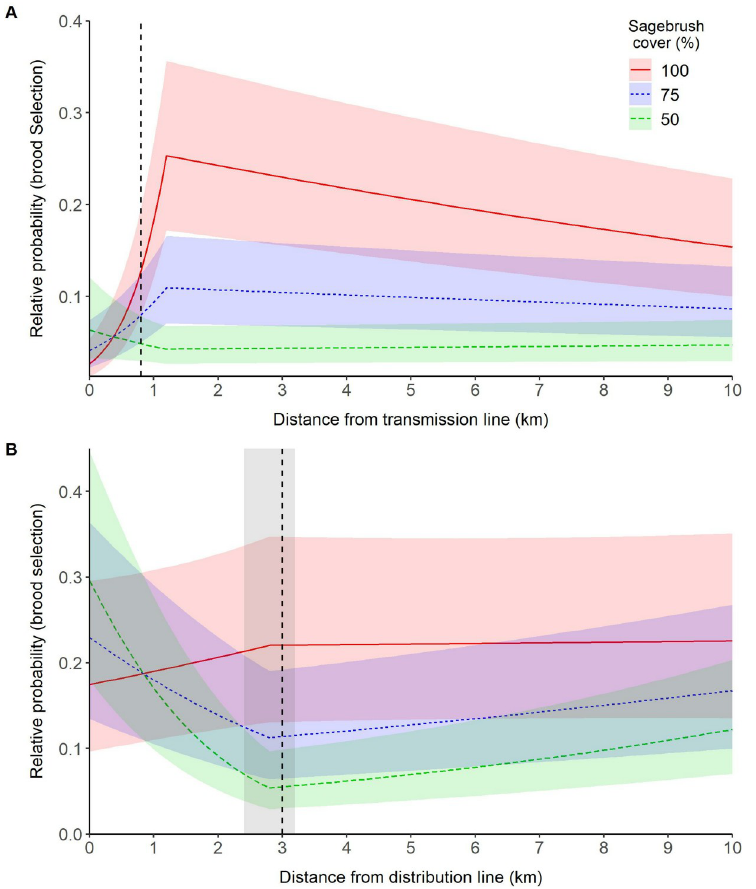
Fig 4. Effect of power lines on the relative probability of greater sage-grouse ( Centrocercus urophasianus ; sage- grouse) brood site selection in Utah, portions of southeastern Idaho, and southwestern Wyoming, USA, 1998– 2013. Lines are population-averaged fitted values from the best-fit GLMM (S4 Appendix) describing the effects of transmission lines (A) and distribution lines (B) on sage-grouse brood site selection. The vertical dashed line identifies the response threshold at which sage grouse response changes. The shaded areas highlight uncertainty ( Δ AICc < 2) around the location of the response threshold (no uncertainty was recorded for distance from transmission lines).